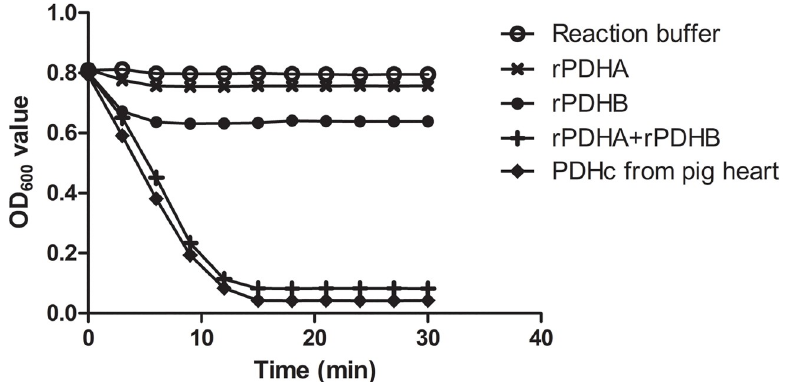
Fig 2. Enzymatic activity assay. Enzymatic activities of purified rPDHA and rPDHB measured by reduction of 2,6-DCPIP at OD 600 . Equimolar mixtures of rPDHA and rPDHB had similar enzymatic activity as the positive control, porcine heart PDHc. The rPDHB had weak enzymatic activity while rPDHA had no detectable enzymatic activity, similar to the negative